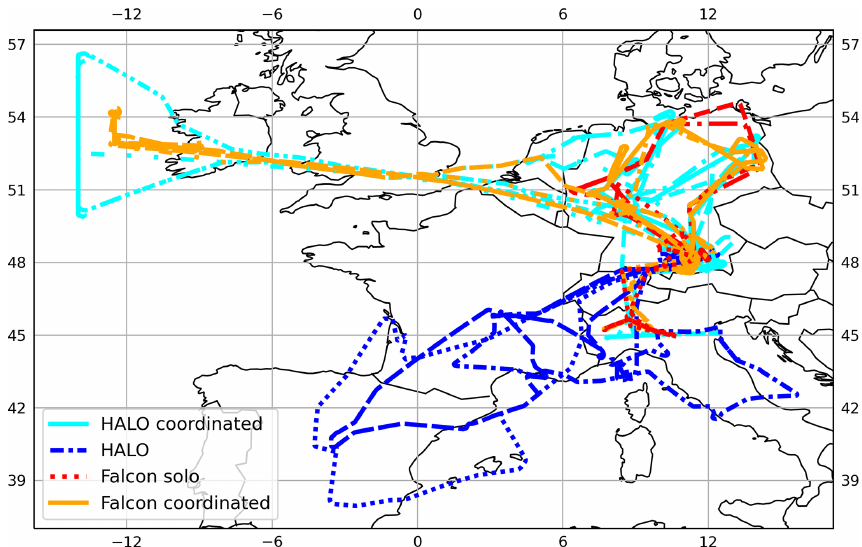
Figure 1. Overview of all flight tracks performed by Falcon (red) and HALO (blue) during the BLUESKY mission in May and June 2020 during the COVID-19 lockdown. Coordinated flights ( Falcon : orange; HALO : cyan) were performed over Germany on 23, 26, and 28 May and twice (30 May and 2 June) as both aircraft headed towards the North Atlantic, west of